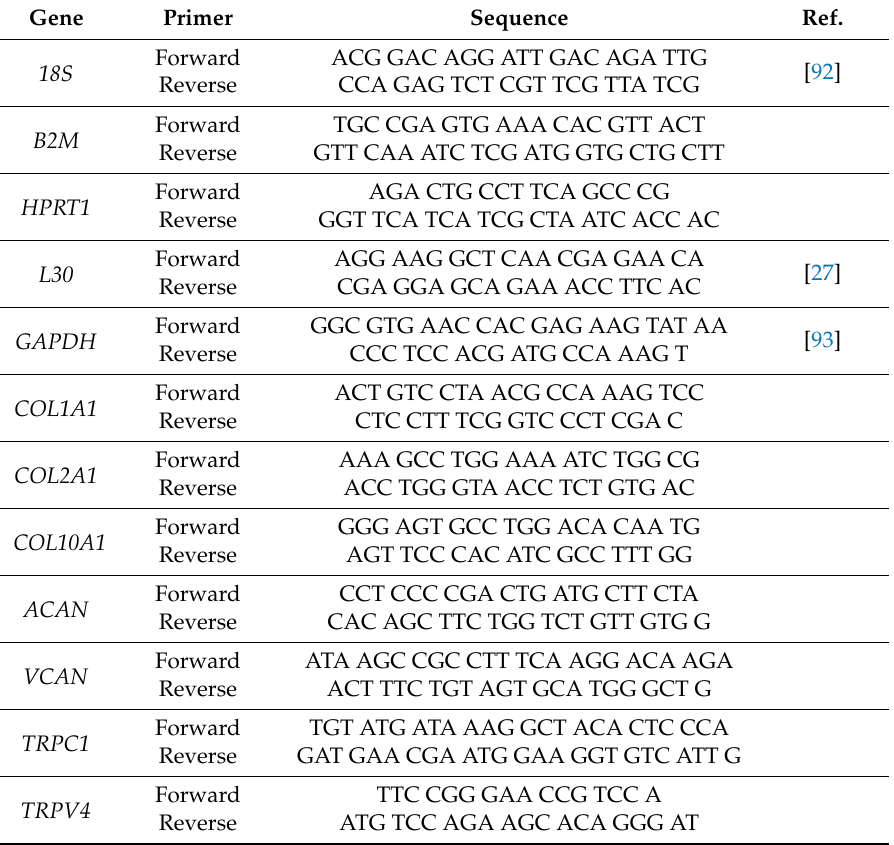
Table 3. List of primer pairs. If no reference is given, the primers were designed with the Primer-BLAST tool from the National Center for Biotechnology Information